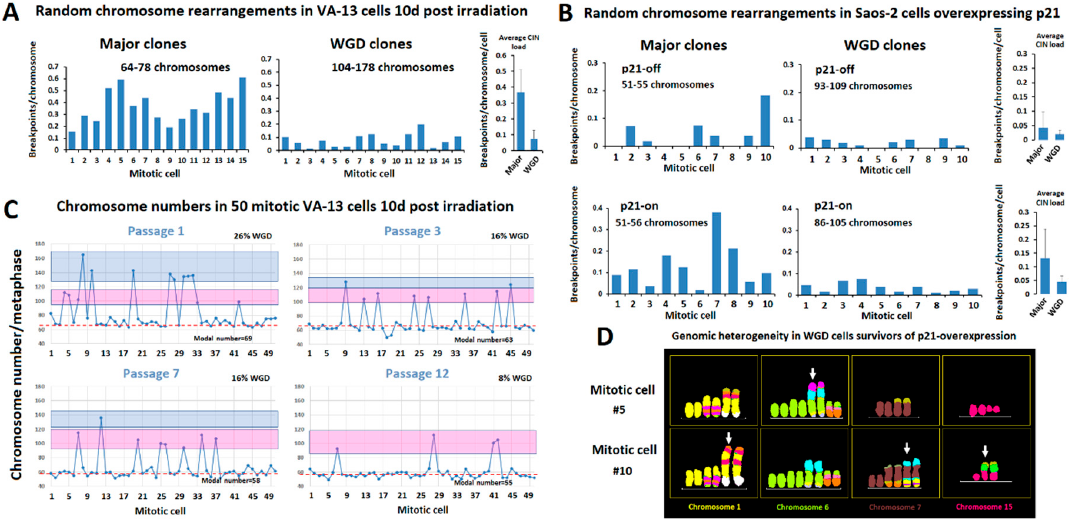
Figure 3. Polyploidization protects the abnormal cancer genome from ongoing structural chromosome aberrations and promotes intratumor heterogeneity. ( A ) Karyotypic analysis in two groups of 15 VA-13 cells, harvested 10 days after exposure to gamma irradiation, reveals significantly lower rates of random structural CIN in the cells that have undergone 1 or 2 rounds of WGD (composed from 104–178 chromosomes) as compared to those undergoing mitosis of the major VA-13 clones (composing of 64–78 chromosomes). Structural CIN was calculated as breakpoints/chromosome/cell. ( B ) Similar results were obtained in the osteosarcoma Saos-2 cells suffering from DNA replication stress upon prolonged p21 overexpression that duplicates the average structural CIN load. ( C ) Distribution of chromosome counts in 50 co-dividing VA-13 cells harvested in subsequent passages after 2.4 Gy of gamma irradiation (1 passage = 2–4 days in culture). Red dotted line represents chromosome numbers proximal to major clones. Pink boxes include cells that underwent one round of WGD. Blue boxes include cells that underwent more than one round of WGD. Note that despite the decline in the rates of WGD by time in culture, very few intermediate chromosome counts were recorded between the distinct ploidy indices, suggesting that cells with heavily unbalanced DNA content are less proficient at dividing. ( D ) M-FISH pseudo colored partial karyotypes of two WGD clones, generated with p21-overexpression-mediated genome reshuffling, display duplicated copies of novel complex recombinant chromosomes (arrows) not observed in non-endoreduplicated cells, suggesting that WGD increases tolerance of novel structural aberrations and thus contributes to genomic heterogeneity.